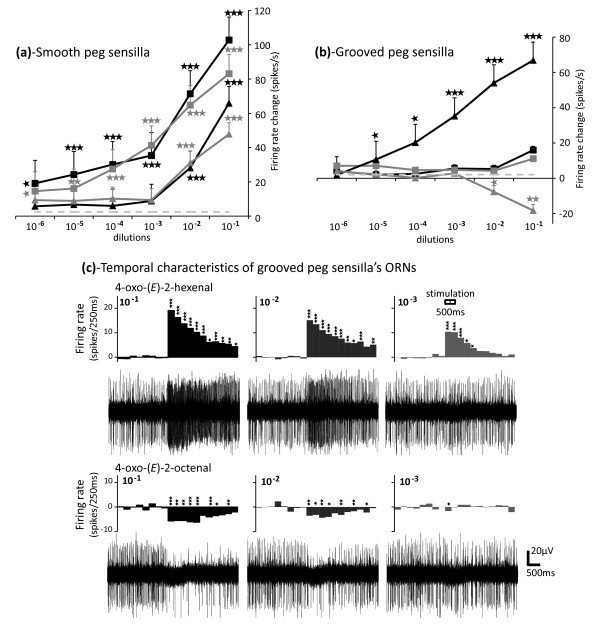
Dose-dependent responses of olfactory receptor neurons housed in antennal olfactory peg sensilla of Cimex lectularius. (A, B) Extracellular recordings of olfactory receptor neurons housed in (a) smooth- and (b) grooved-peg sensilla reveal dose-dependent responses to (E)-2-hexenal (black squares), (E)-2-octenal (grey squares), 4-oxo-(E)-2-hexenal (black triangles) and 4-oxo-(E)-2-octenal (grey triangles). The points represent an average over six to 26 replicates and error bars correspond to the standard error of mean. (c) Temporal response characteristics of olfactory receptor neurons housed in the grooved peg sensilla. Histogram bars represent firing rate changes due to injection of 4-oxo-(E)-2-hexenal (n = 15) and 4-oxo-(E)-2-octenal (n = 6) within a sampling period of 250 ms each. The 500 ms stimulation started 2 s after the beginning of the recording (9th and 10th bins). Asterisks indicate statistically significant responses compared to the control, calculated by Mann Whitney U-test with * P < 0.05, ** P < 0.01 and *** P < 0.001.